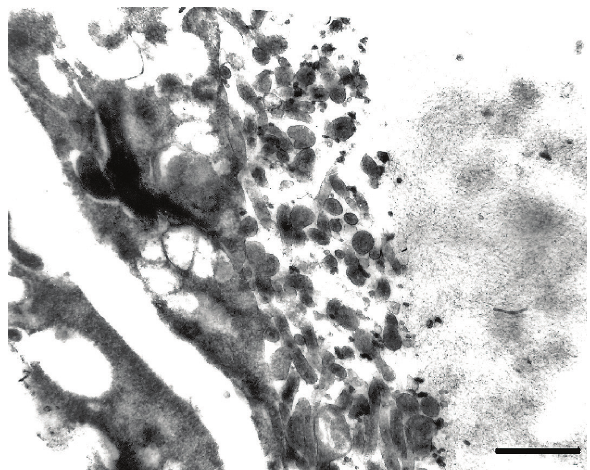
Figura 2. Embrião do grupo contaminado após o 4º dia de desenvolvimento em microscopia eletrônica de transmissão (aumento de 10.000x). (A) Zona pelúcida. (B) Citoplasma. As setas indicam estruturas semelhantes às da